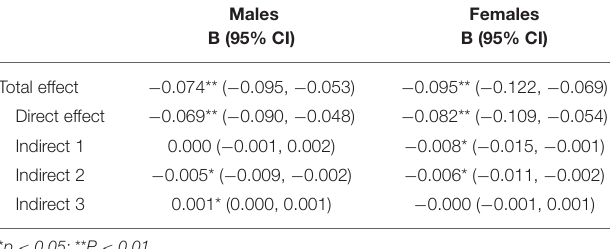
TABLE 3 | Regression analysis on the predictors of self-image at wave 9.